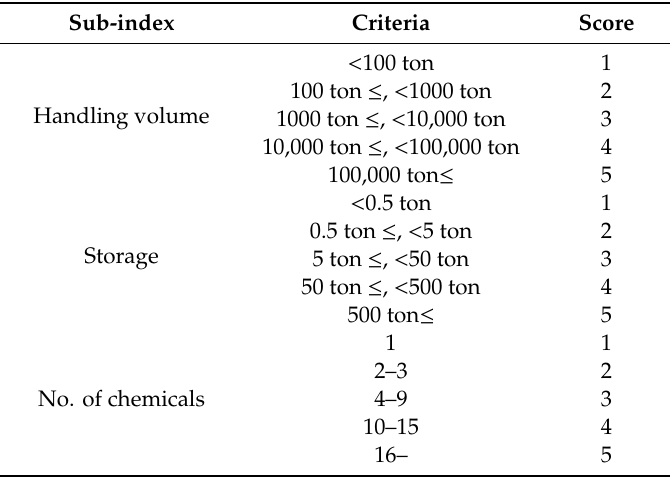
Table A2. Criteria and score of the plant factor